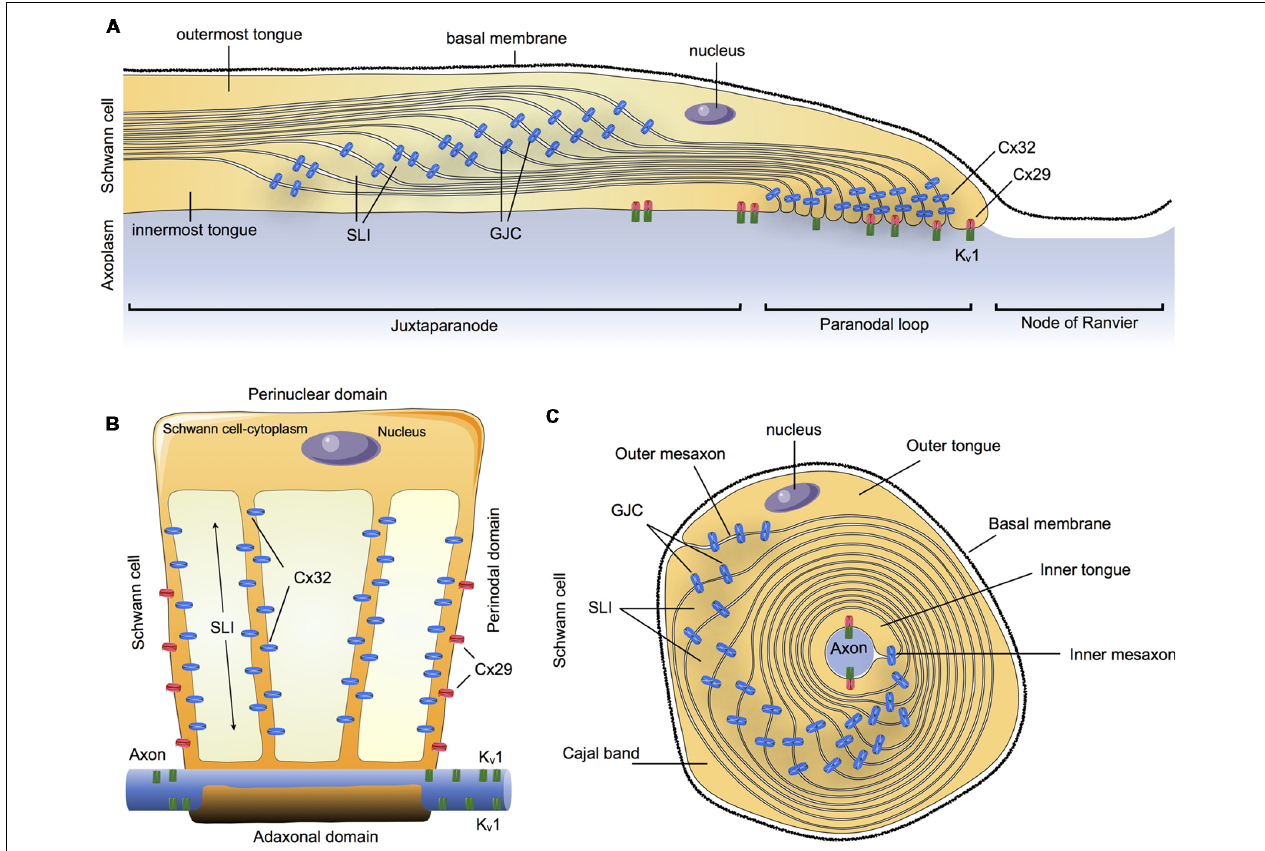
FIGURE 1 | Schematic summary of connexins (Cxs) in the communication of myelin sheath in Schwann cells (SCs). (A) Longitudinal view of myelinated SCs showing the different compartments: outermost tongue, innermost tongue, Schmidt-Lanterman incisures (SLI) and the distribution of the connexins forming gap junction channels (GJCs) or hemichannels (HCs) formed by Cxs (Cx HCs) along the juxtaparanode, paranodal loop or the node of Ranvier. (B) Myelinated SCs unwrapped from the axon it invests. (C) Transversal view. Cx29, connexin29; Cx32, connexin 32; K v 1, Potassium voltage-gated channel subfamily